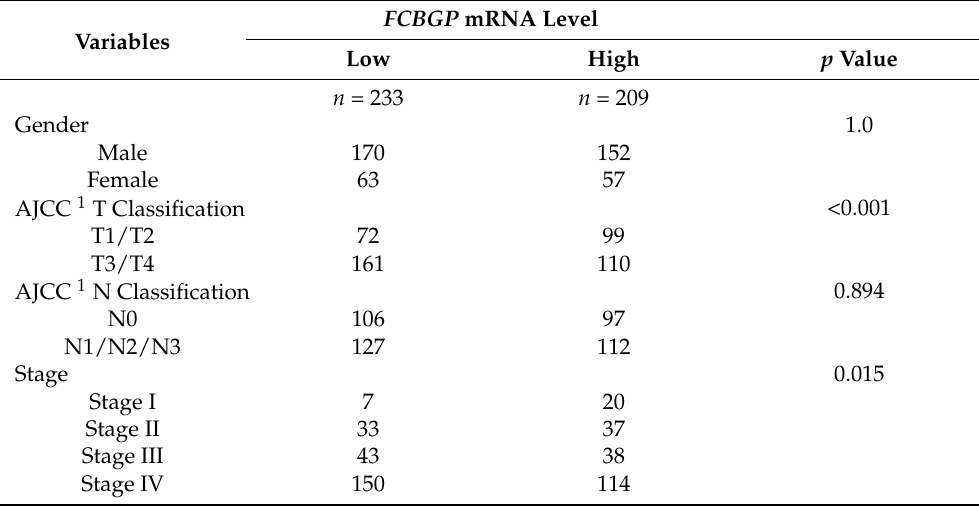
Table 1. Correlations between clinical factors and the FCGBP mRNA